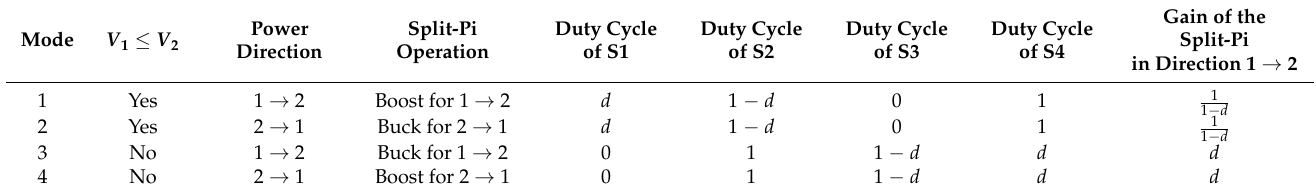
Table 1. Summary of the operating modes of the Split-pi